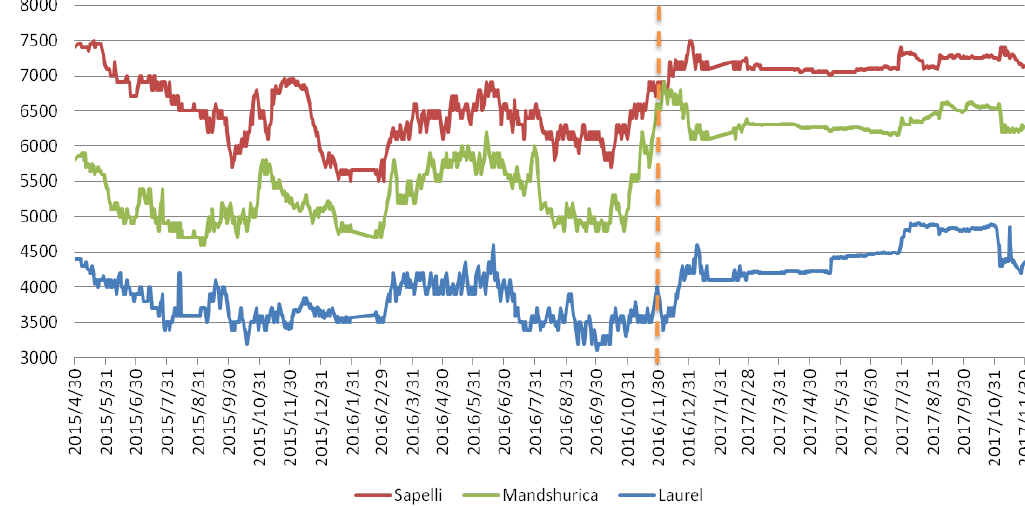
Figure 1. The price series of three species of hardwood lumber imported by China between 30 April 2015 and 30 November 2017 (unit: CNY/m 3 ).